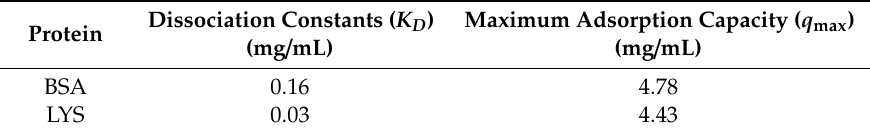
Figure 4. Adsorption of BSA and LYS on CB3GA-Cellulose-2 adsorbent. The plots depict the equilibrium in liquid phase protein concentration (c, mg/mL) vs. the equilibrium in solid-phase protein concentration (q, mg/mL adsorbent). ( a ) Langmuir isotherm of the absorption of BSA. ( b ) Linear regression of the Langmuir equation for BSA. ( c ) Langmuir isotherm of the absorption of LYS. ( d ) Linear regression of the Langmuir equation for LYS. Table 1. Langmuir parameters for the interaction of BSA and LYS with the CB3GA-Cellulose-2 affinity adsorbent.